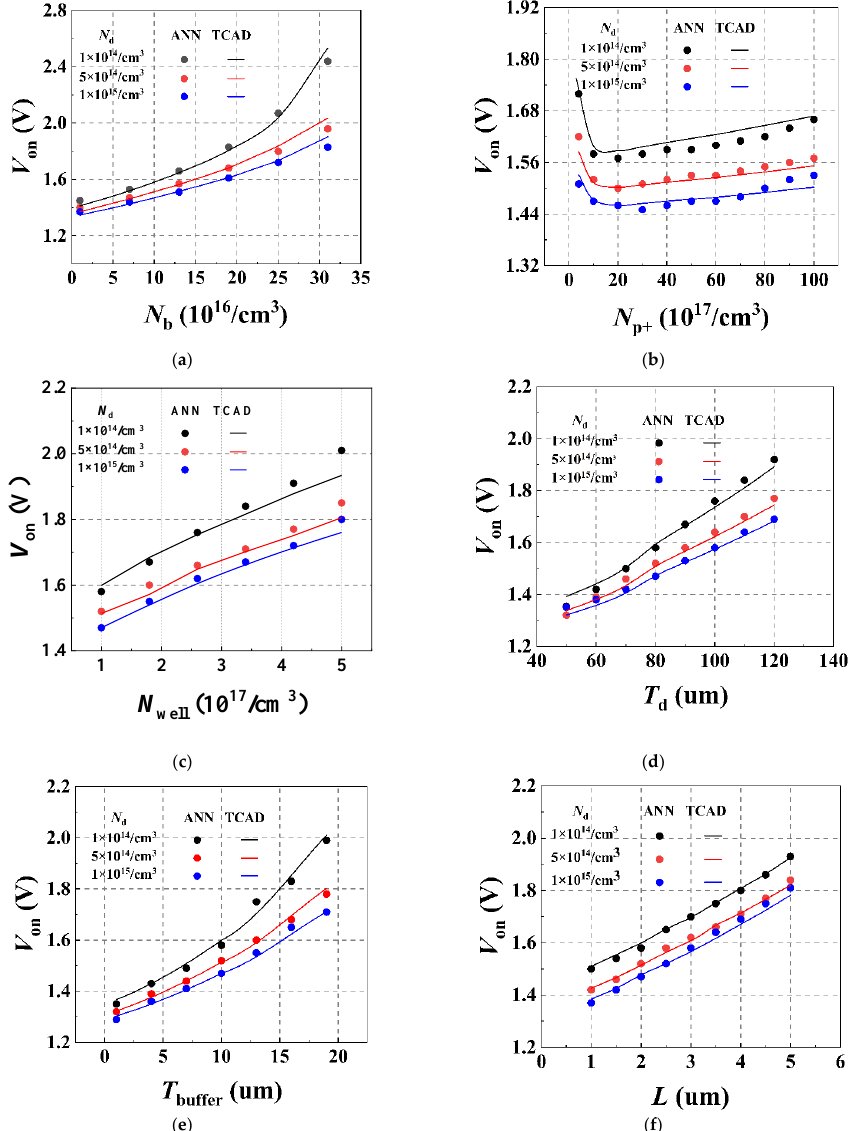
Figure 6. ( a – f ) Comparison of predicted results from ANN and TCAD for the V on of devices under the condition that six structural parameters N b , N p+ , N well , T d , T buffer , and L are changed, respectively.